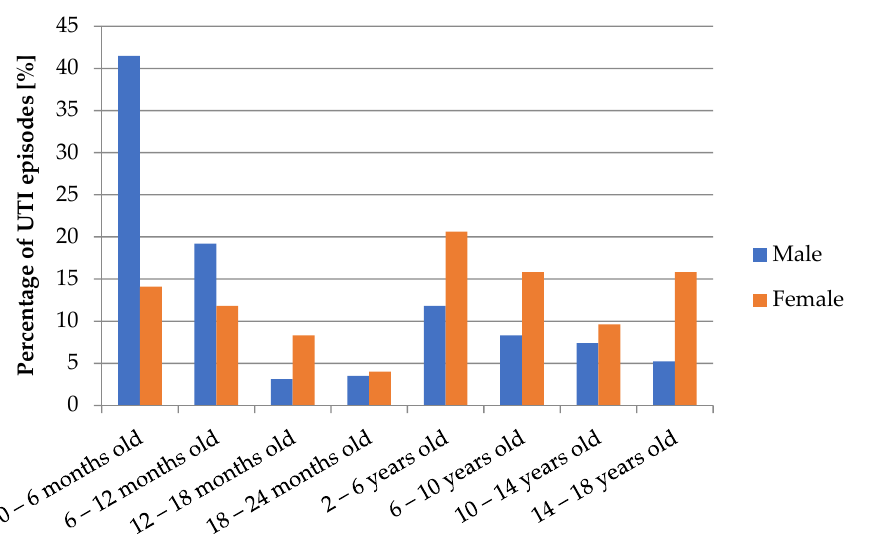
Figure 1. Number of UTI episodes depending on age and gender of patients.